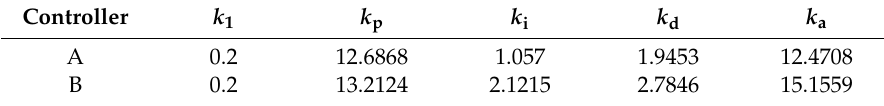
Table 4. Optimized controller parameters of recurrent single-objective PSO.